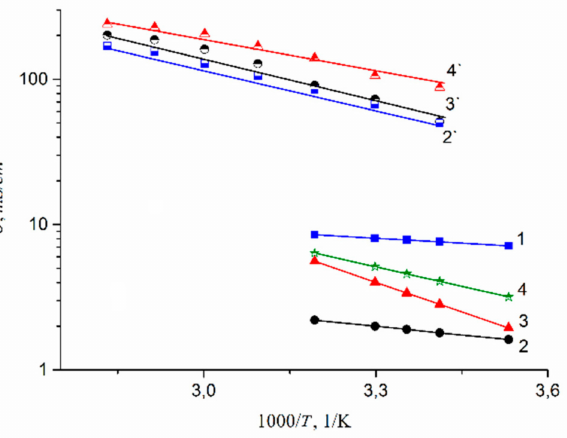
Figure 42. Temperature dependences of experimental σ exp (1–4) and calculated σ calc (2 (cid:48) –4 (cid:48) ) ionic conductivities in H + (1), Li + (2) and (2 (cid:48) ), Na + (3) and (3 (cid:48) ), Cs + (4) and (4 (cid:48) ) ionic forms of MSC membrane at RH